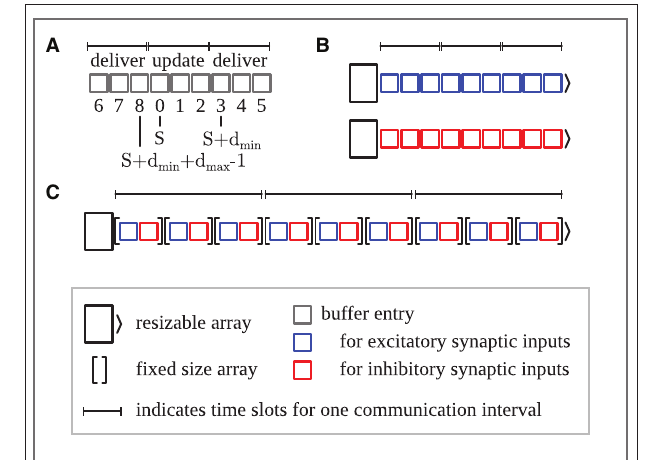
FIGURE 8 | Neuronal input buffers accounting for synaptic delays in simulations of spiking neuronal networks. (A) Structure of neuronal